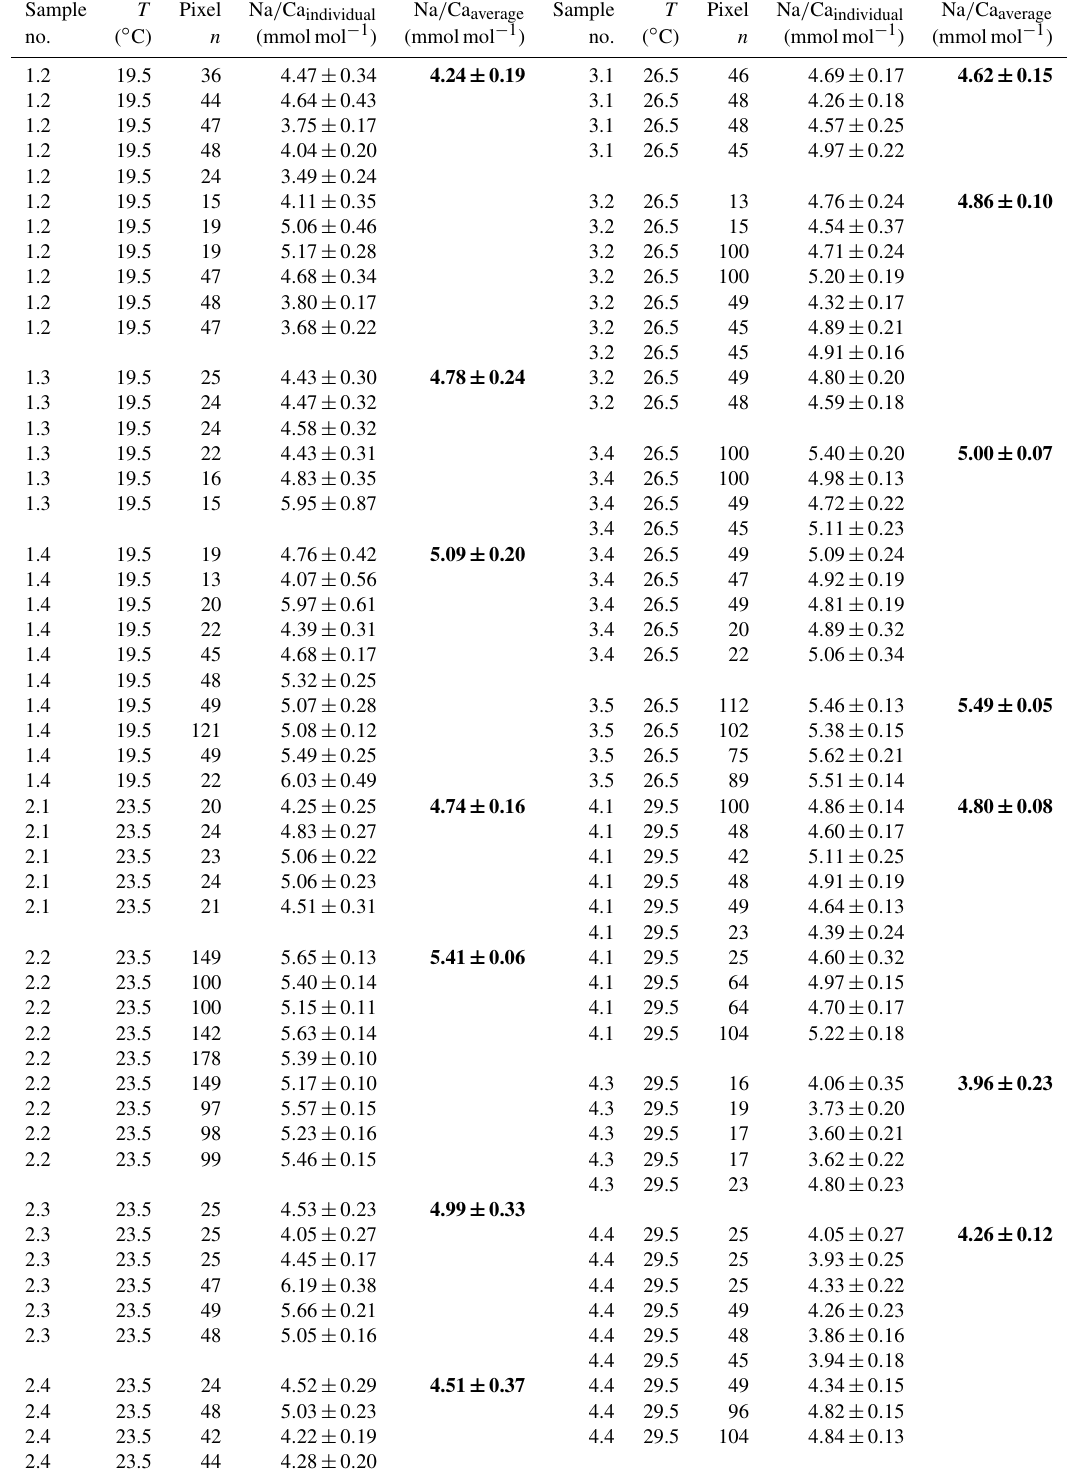
Table 4. Individual Na / Ca values of cultured T. sacculifer under variable temperatures ( T ) and a constant salinity of 36, measured by the electron microprobe. Each value results from maps, ranging in size from 5 to 20µm, on inner chamber wall cross sections of newly grown calcite (F, F-1) during the experiments. Each pixel represents 1µm × 1µm. Averaged values (bold) comprise all Na / Ca values of one single foraminifer. Sample labels correspond to those used in Nürnberg et al. (1996). Individual and averaged Na / Ca values are based on ± standard √ n error of the mean ( σ/